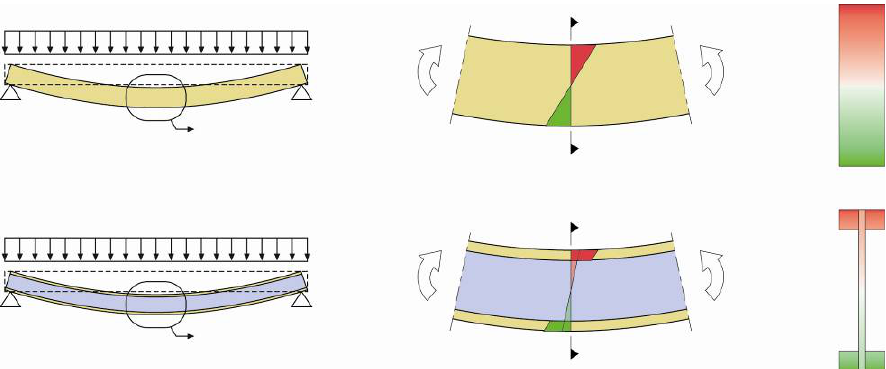
Figure 3: Flexural stress distribution in a simple beam and in the composite